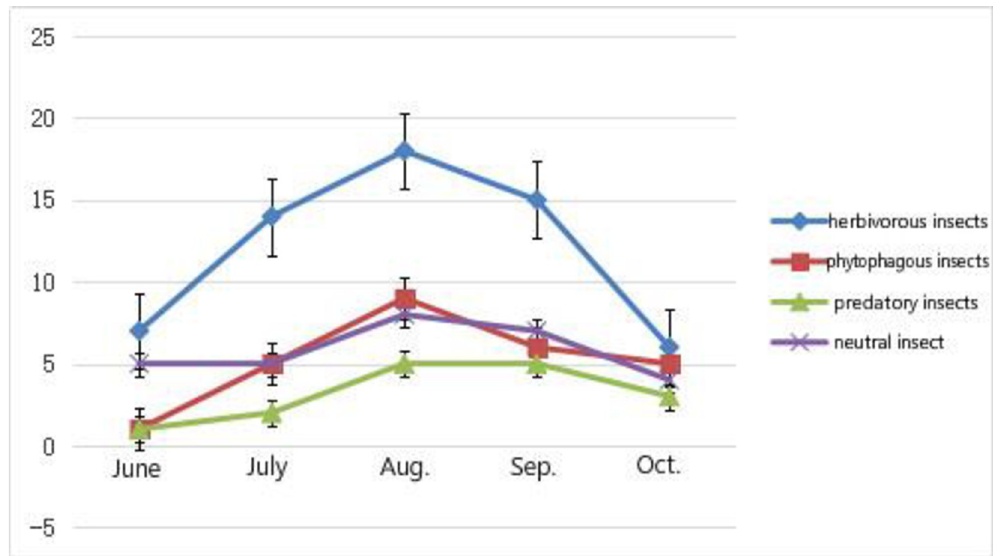
Fig 5. Farmland insect functional group species number changes with time. The four functional group species number of insect communities in corn farmland: herbivorous insects, predatory insects, parasitic insects and neutral insects change with the